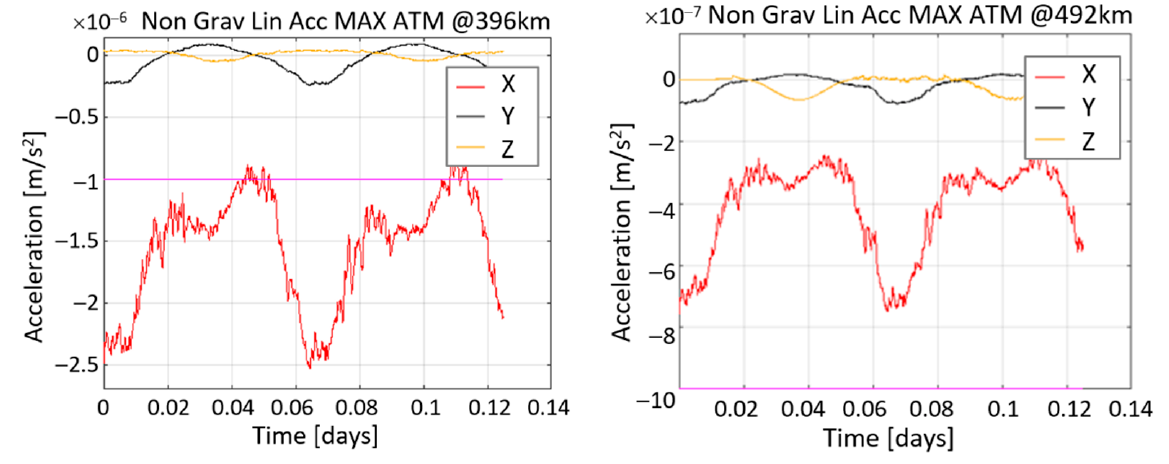
Figure 15. Drag acceleration components over 2 orbits at 396 km and 492 km, computed at the epoch of maximum solar activity with 95th percentile on F 10.7 and A p prediction.